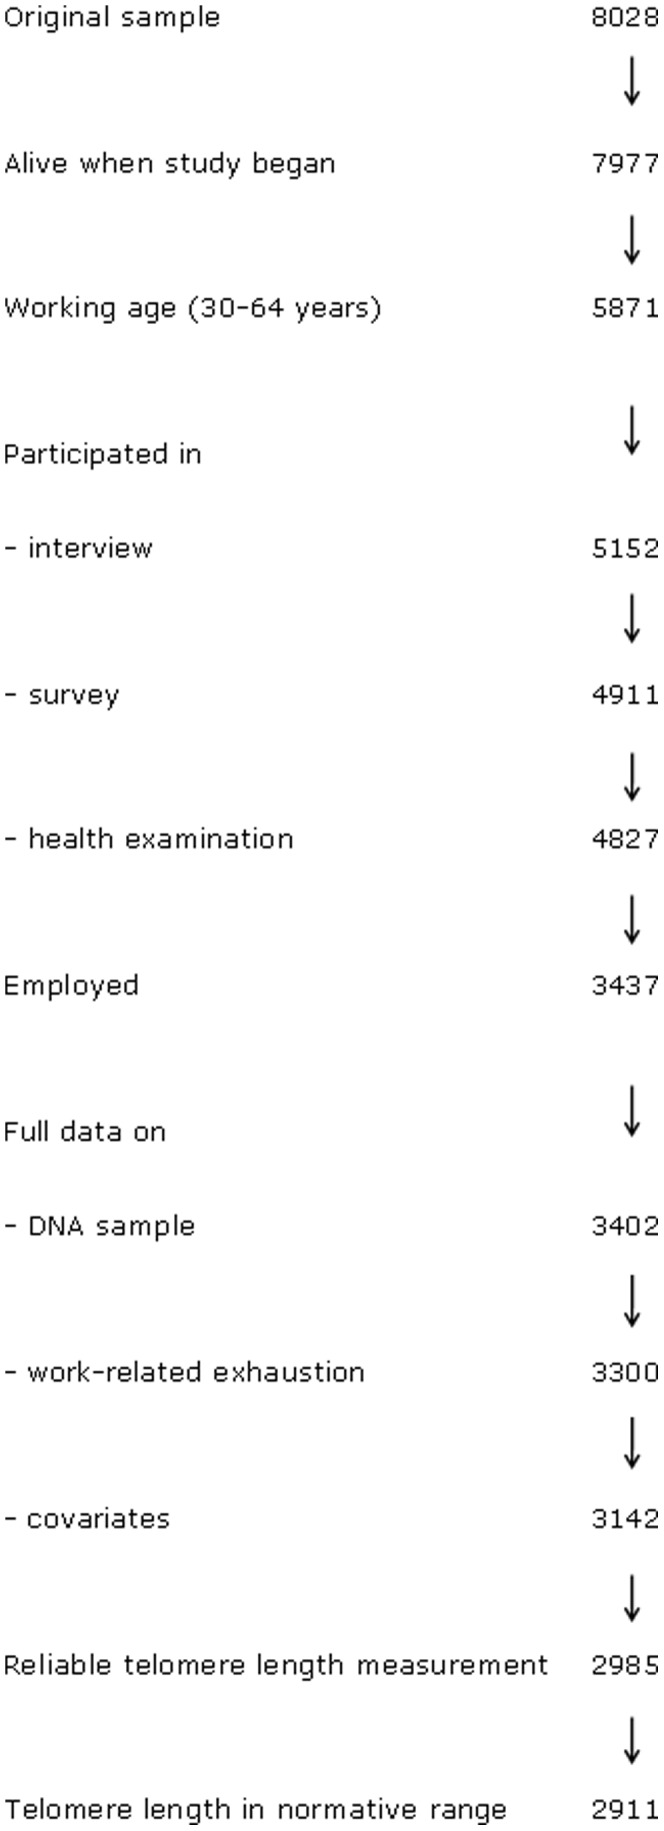
Sample selection.